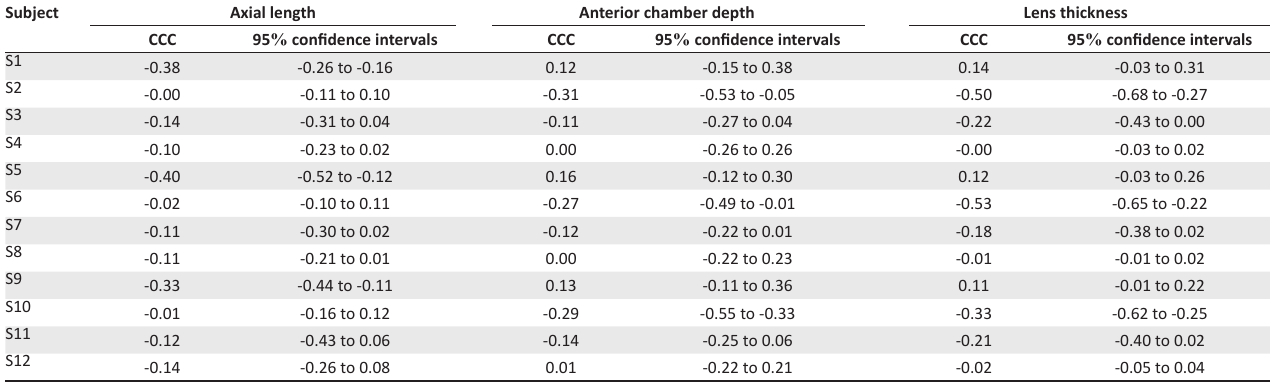
TABLE 3: Concordance correlation coefficients with associated 95 % confidence intervals alongside the Concordance correlation coefficients for each